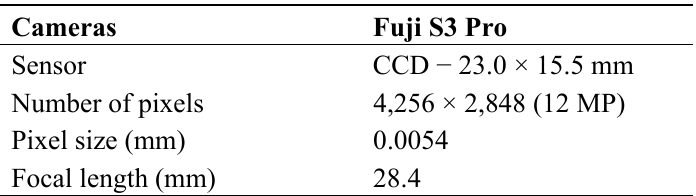
Table 1. Technical details of the camera